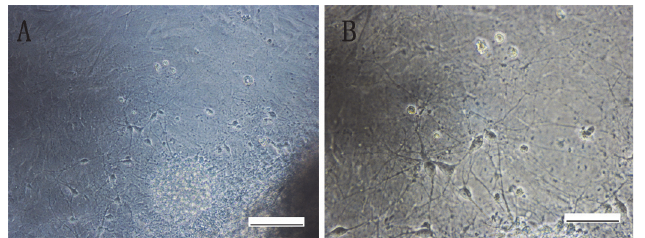
Fig 6. Differentiation of iNSCs in vitro under microscopic observation. Differentiated cells gradually migrated from neurospheres two days after adherence (A). Seven days later, neurites and differentiated cells were observed around the adherent iNSCs (B and C). Scale bars = 200 μ m (A), 100 μ m (B).